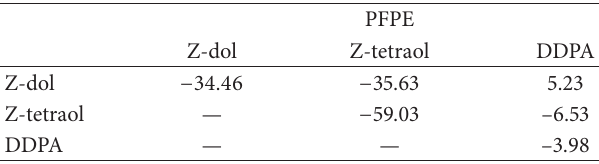
Table 7: Endbead-endbead interaction ( 𝜀 𝑝 ) between PFPEs, that is, Z-dol, Z-tetraol, and DDPA